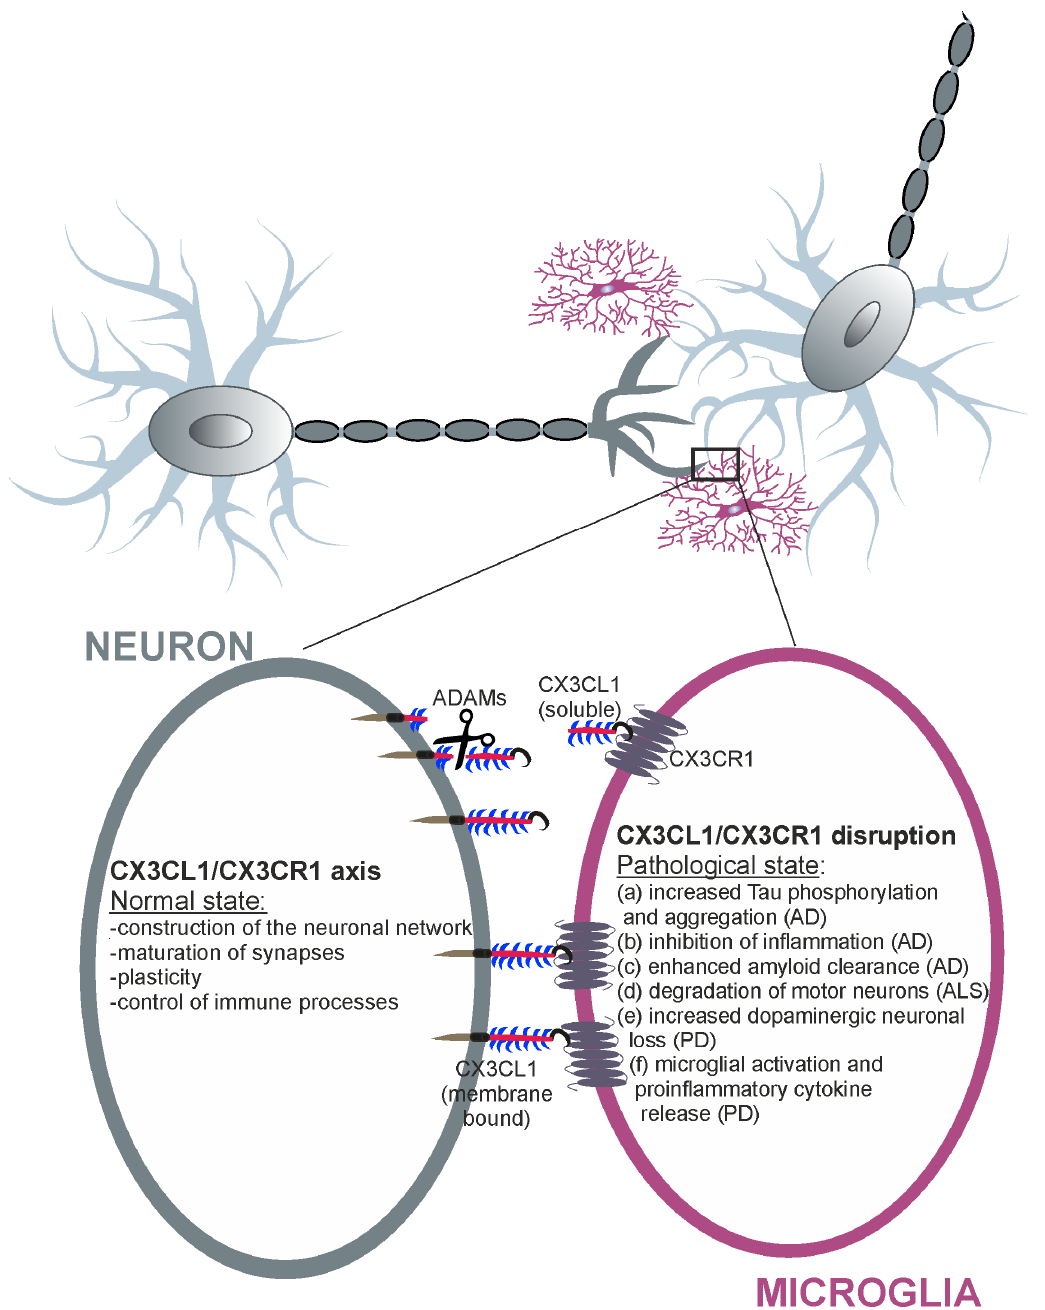
Figure 2. CX3CL1-CX3CR1 signaling between microglia and neurons in physiological and neuropathological conditions. Fractalkine is a membrane-bound or soluble molecule. CX3CL1 bound to the membrane is important for cell adhesion and acts as an “off” signal for microglia. The cleavage of fractalkine is achieved by the ADAM10 and ADAM17 proteases, and this soluble form of CX3CL1 acts as a chemoattractant for inflammatory cells. Disruption of CX3CL1-CX3CR1 signaling in neuropathological diseases may lead to neuroprotective (b, c) and detrimental (a, d, e, f, g)